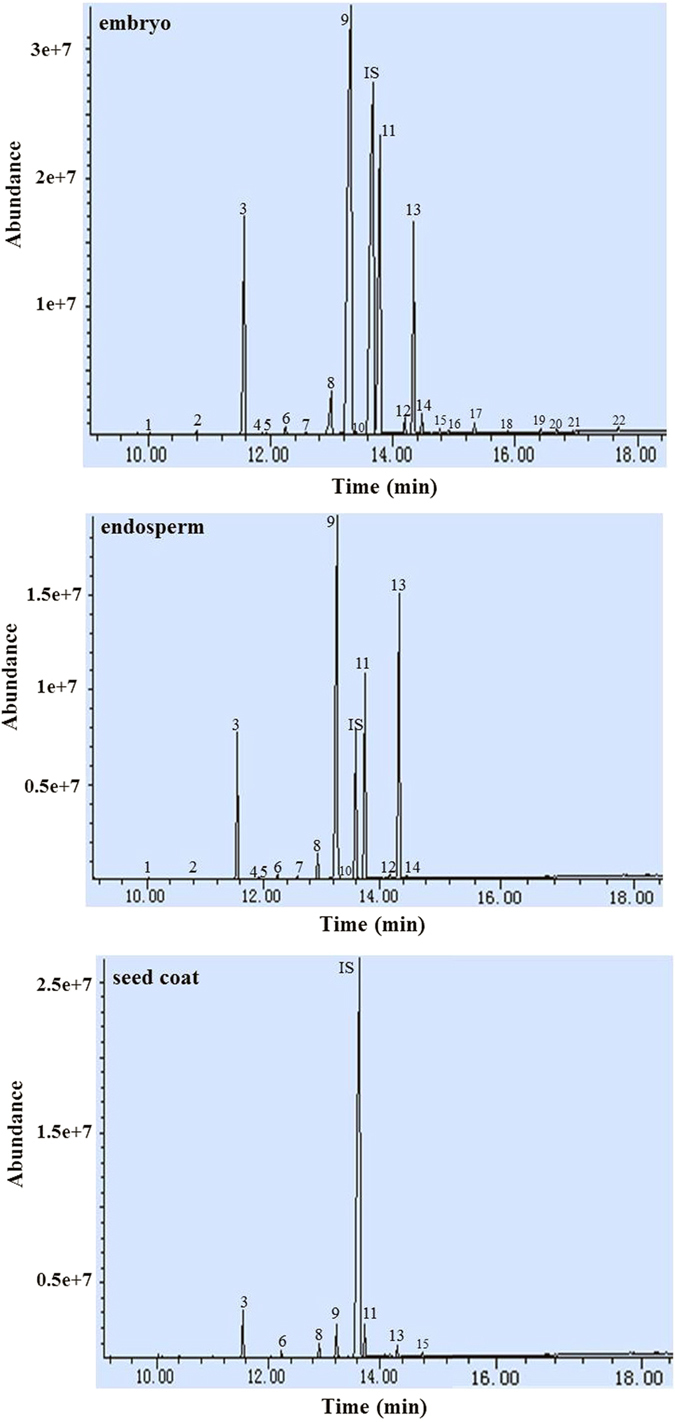
GC–MS of fatty acid methyl esters in embryo, endosperm and seed coat of Paeonia ludlowii.1: C14:0; 2: C15:0; 3: C16:0; 4: C16:1Δ7; 5: C16:1Δ9; 6: C17:0; 7: C17:1Δ10; 8, C18:0; 9: C18:1Δ9; 10: C18:1Δ11; 11: C18:2Δ9,12; 12: C20:0; 13: 18:3Δ9,12,15; 14: C20:1Δ11; 15: C21:0; 16: C20:2Δ11,14; 17: C22:0; 18: C22:1Δ13; 19: C23:0; 20: C24:0; 21: C24:1Δ15; 22: C25:0; IS: internal standard, nonadecanoic acid.